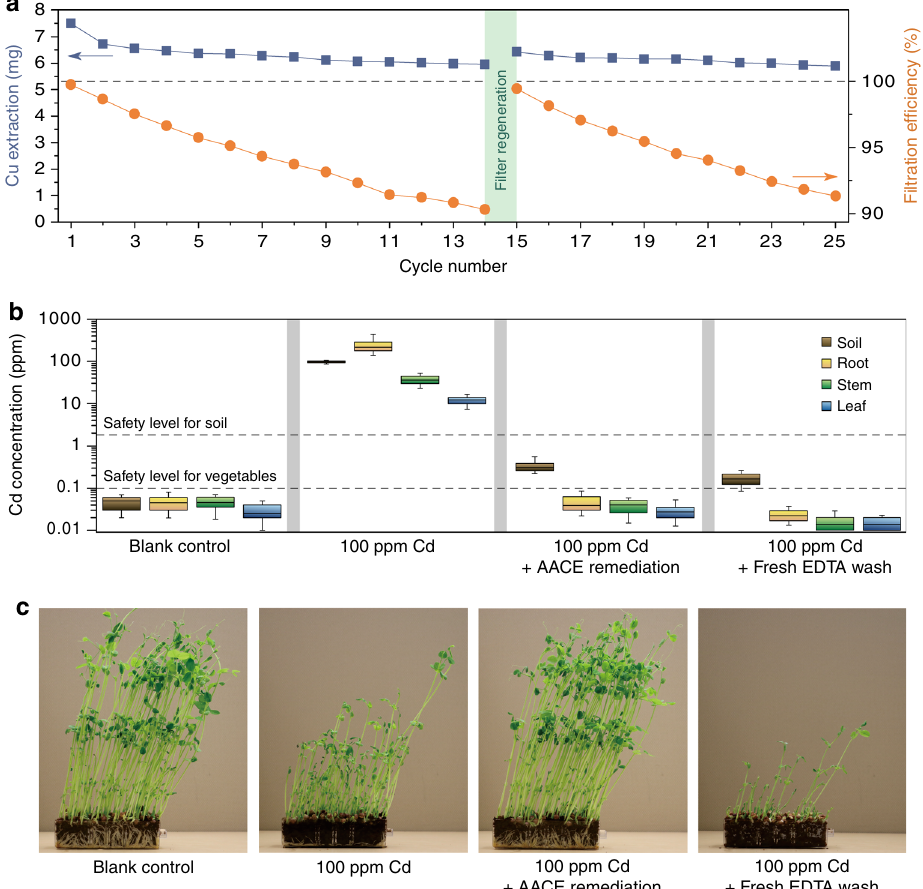
Fig. 4 Long-term performance and plant assay. a Extraction ability of the recycled EDTA solution and the AACE fi ltration ef fi ciency as functions of treatment cycles. Total 25 contaminated soil samples (10,000 ppm Cu) were prepared. In each cycle, the same EDTA solution was used to wash a contaminated soil sample followed by the AACE fi ltration, and the extraction ability of the EDTA solution was examined by the mass of Cu extracted from the soil. The AACE fi lter was regenerated by acid elution after the 14th cycle. b , c Plant assay using pea (Pisum sativum) sprouts. After the AACE remediation, the Cd level in the planted pea sprouts met the International Food Standards. Using fresh EDTA to wash the contaminated soil caused stunted growth of the pea sprouts. Boxplots represent median, 25th and 75th percentile. Whiskers indicate the maximum and minimum ( n =